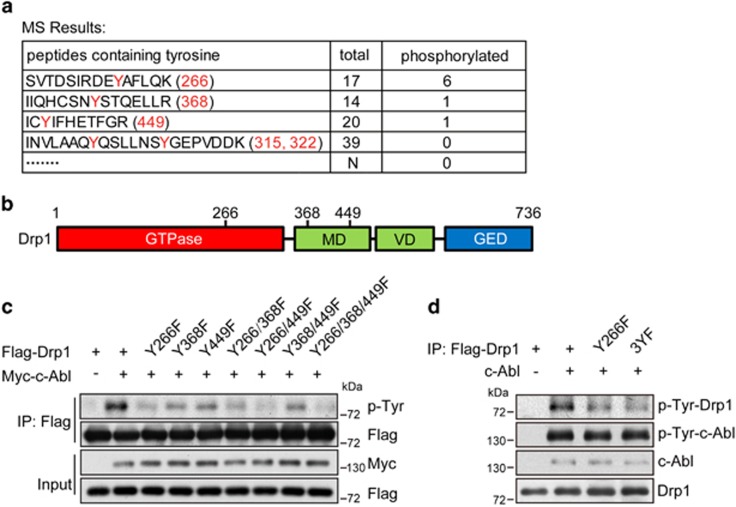
c-Abl phosphorylates Drp1 at Y266, Y368 and Y449. (a) Phosphorylation reactions from Figure 2d were subjected to SDS-PAGE followed by Coomassie Blue staining. The band corresponding to Drp1 was excised from the gel and digested with trypsin. Phosphorylation sites were mapped by microcapillary liquid chromatography-MS/MS, with 92.8% coverage of the Drp1 amino-acid sequence. Three phosphorylated tyrosine sites were identified. (b) Schematic of three phosphorylation sites in the Drp1 protein. (c) Lysates from HEK 293T cells transfected with Flag-Drp1 WT or other Drp1 mutants as indicated and Myc-c-Abl WT expression plasmids were immunoprecipitated with anti-Flag antibody and analyzed by immunoblotting anti-phospho-tyrosine antibody. (d) Immunoprecipitates of Flag-Drp1 WT and Y226F and 3YF mutants transfected in HEK 293T cells were subjected to in vitro kinase assay with c-Abl kinase. Phosphorylation reactions were analyzed by immunoblotting with anti-phospho-tyrosine antibody